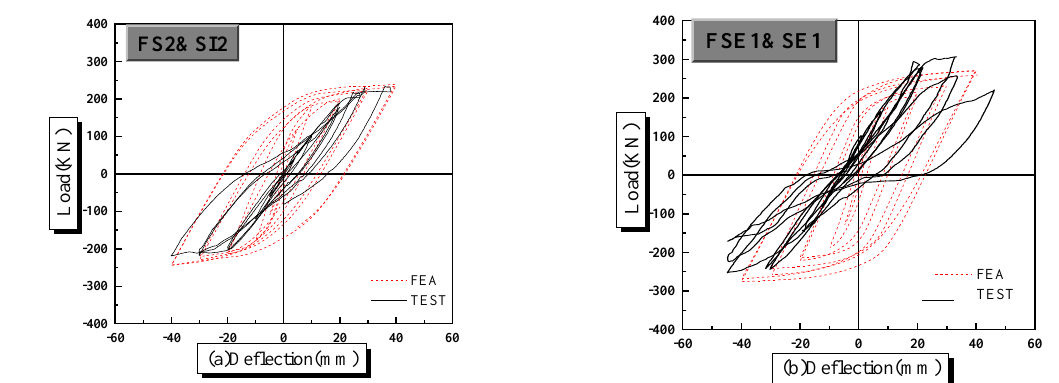
Figure 8. Comparison results of load-deflection hysteretic curves of PPSRC beam–column joints: ( a ) FS2 and SI2; ( b ) FSE1 and SE1.